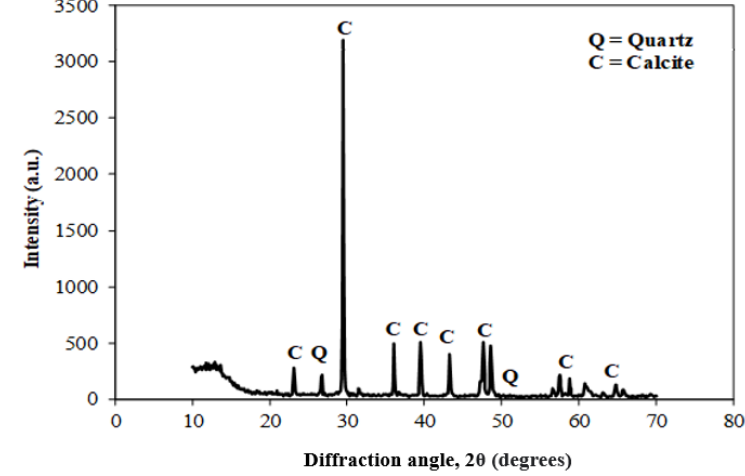
Figure 6. XRD of coal ash.